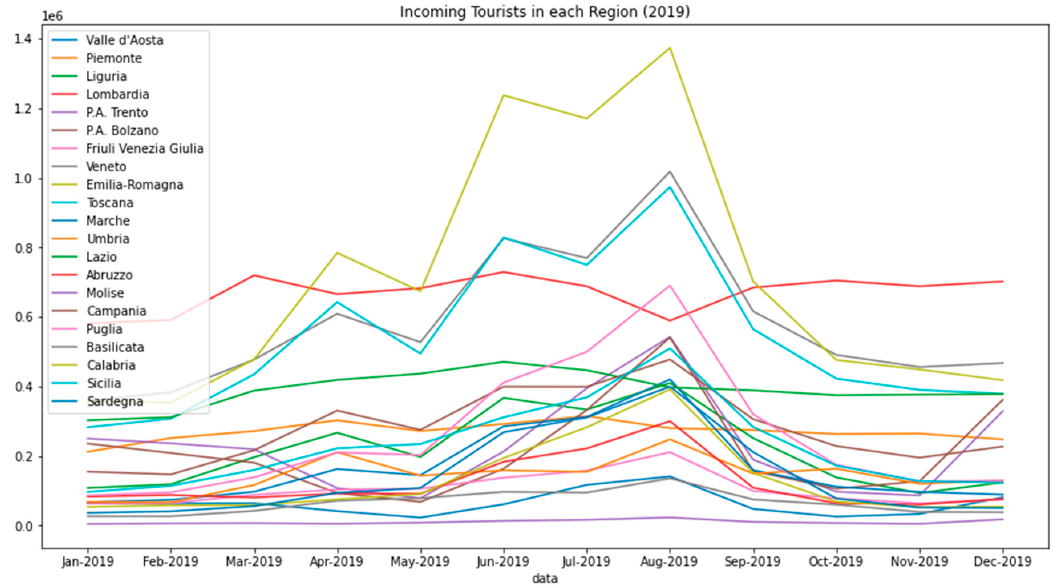
Figure 2. Incoming domestic tourists per each Italian region for each month of 2019. The y axis is arrivals per million. Typically, peaks of the curves are observed in August.